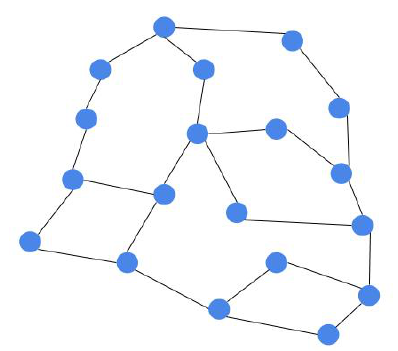
Figure 2. road topology used, Road Side Units distributed